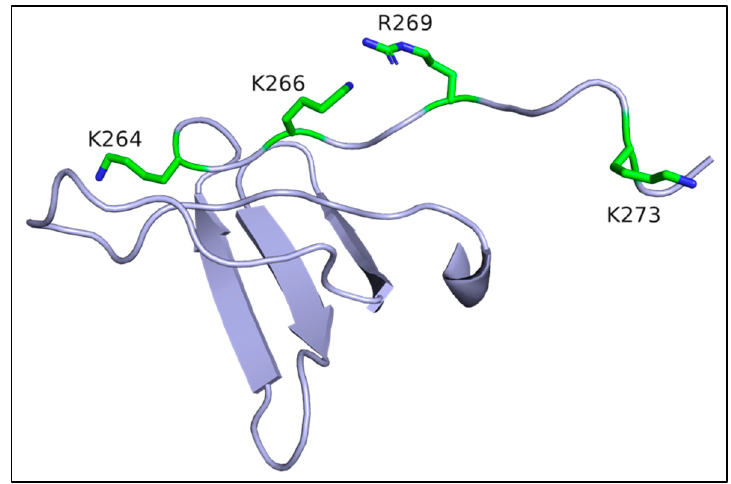
Figure 4. Cartoon representation of the CTD and six downstream residues (amino acids 271–276) of the IN tail region (PDB accession code 5HOT). The side chains of IN residues Lys264, Lys266, Arg269, and Lys273, which are implicated in vRNA binding, are shown as sticks.